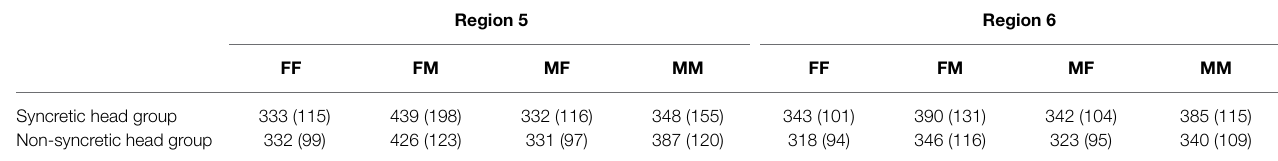
TABLE 3 | Experiment 2: mean RTs (in ms) and standard deviations (in parentheses) in regions 5 and 6 in different experimental